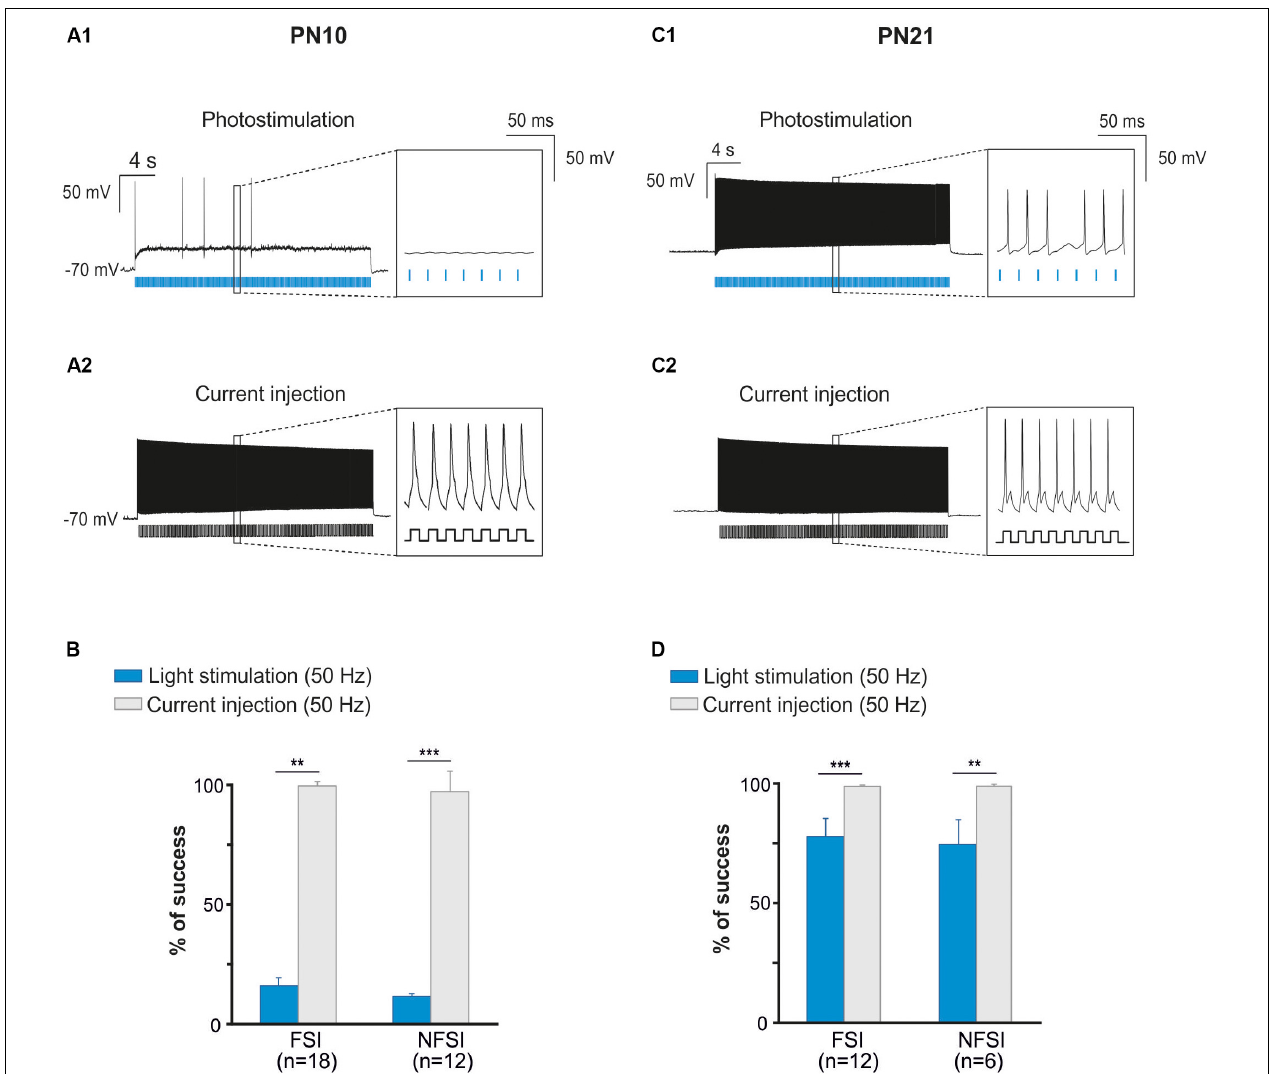
FIGURE 3 | The fail of response at high frequency photostimulation in brain slices at PN10 is not due to interneuron immature membrane properties. (A) An identified ChR2-expressing interneuron recorded in current-clamp mode during a 50 Hz photostimulation protocol (A1) in a brain slice at P10. Note the numerous failures (inset) in response to blue light pulses (blue bars). The same neuron stimulated with current injections (400 pA, 10 ms; (A2) ) at 50 Hz showed virtually no failures (inset). (B) Comparison between the percentage of success of photostimulation versus current stimulation at 50 Hz for FSI and NFSI in mice at PN10. (C) An identified ChR2-expressing interneuron recorded in current-clamp mode during a 50 Hz photostimulation protocol (C1) in a brain slice at PN21. Note the increased number of APs (inset) triggered by photoactivation (blue bars) compared with the interneuron at PN10 (A1) . The same neuron stimulated with current injections (400 pA, 10 ms; C2 ) at 50 Hz showed virtually no failures (insets). (D) Comparison between the percentage of success of photostimulation versus current stimulation at 50 Hz for FSI and NFSI in mice at PN21. ∗∗ p < 0.01 and ∗∗∗ p < 0.001, Mann–Whitney